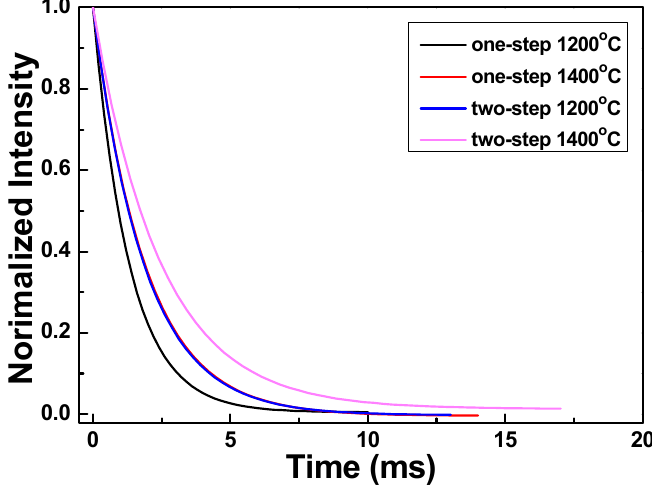
Figure 7. Decay time of BaZrO 3 :Eu 0.025 powders as a function of heating process and heating temperature.